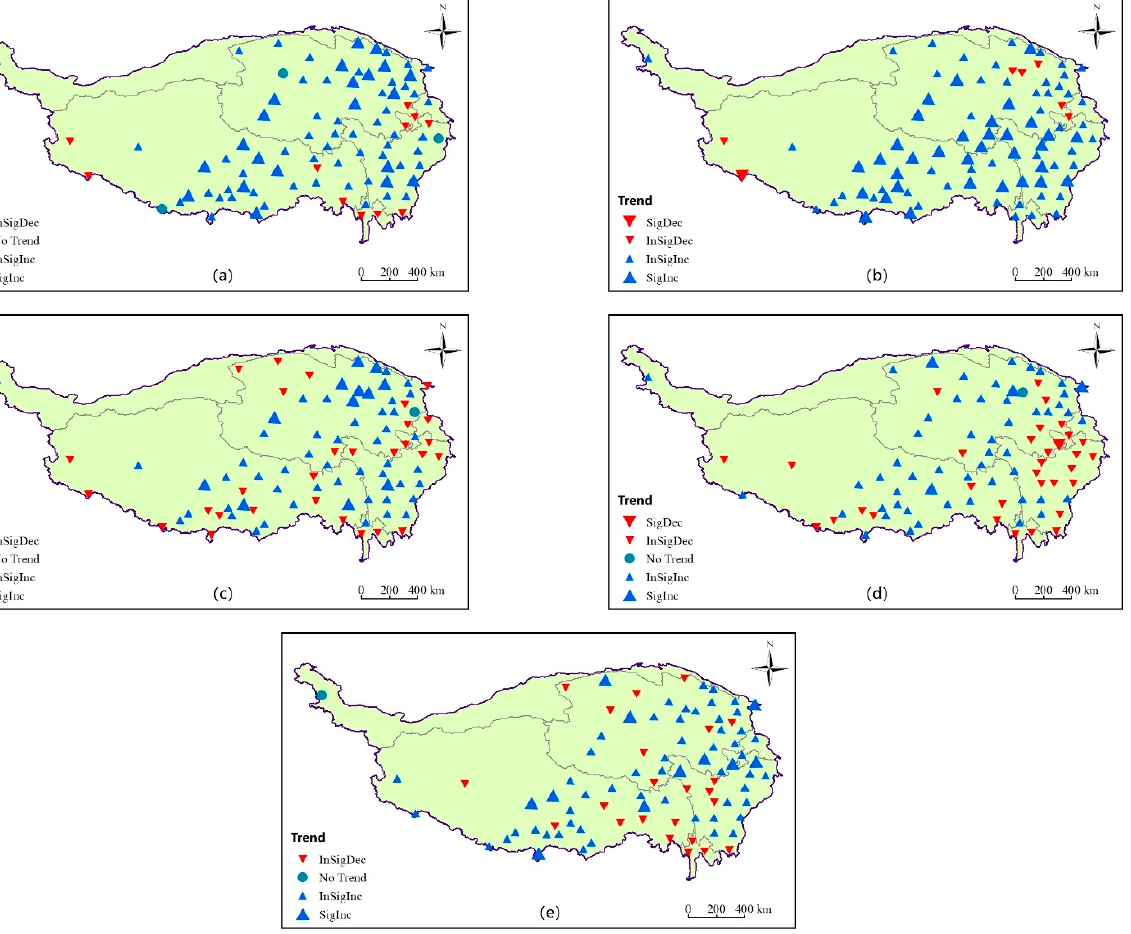
Figure 4. Spatial distribution of precipitation trends at different timescales on the TP in 1966–2016. ( a ) Annual, ( b ) spring, ( c ) summer, ( d ) autumn, ( e ) winter.